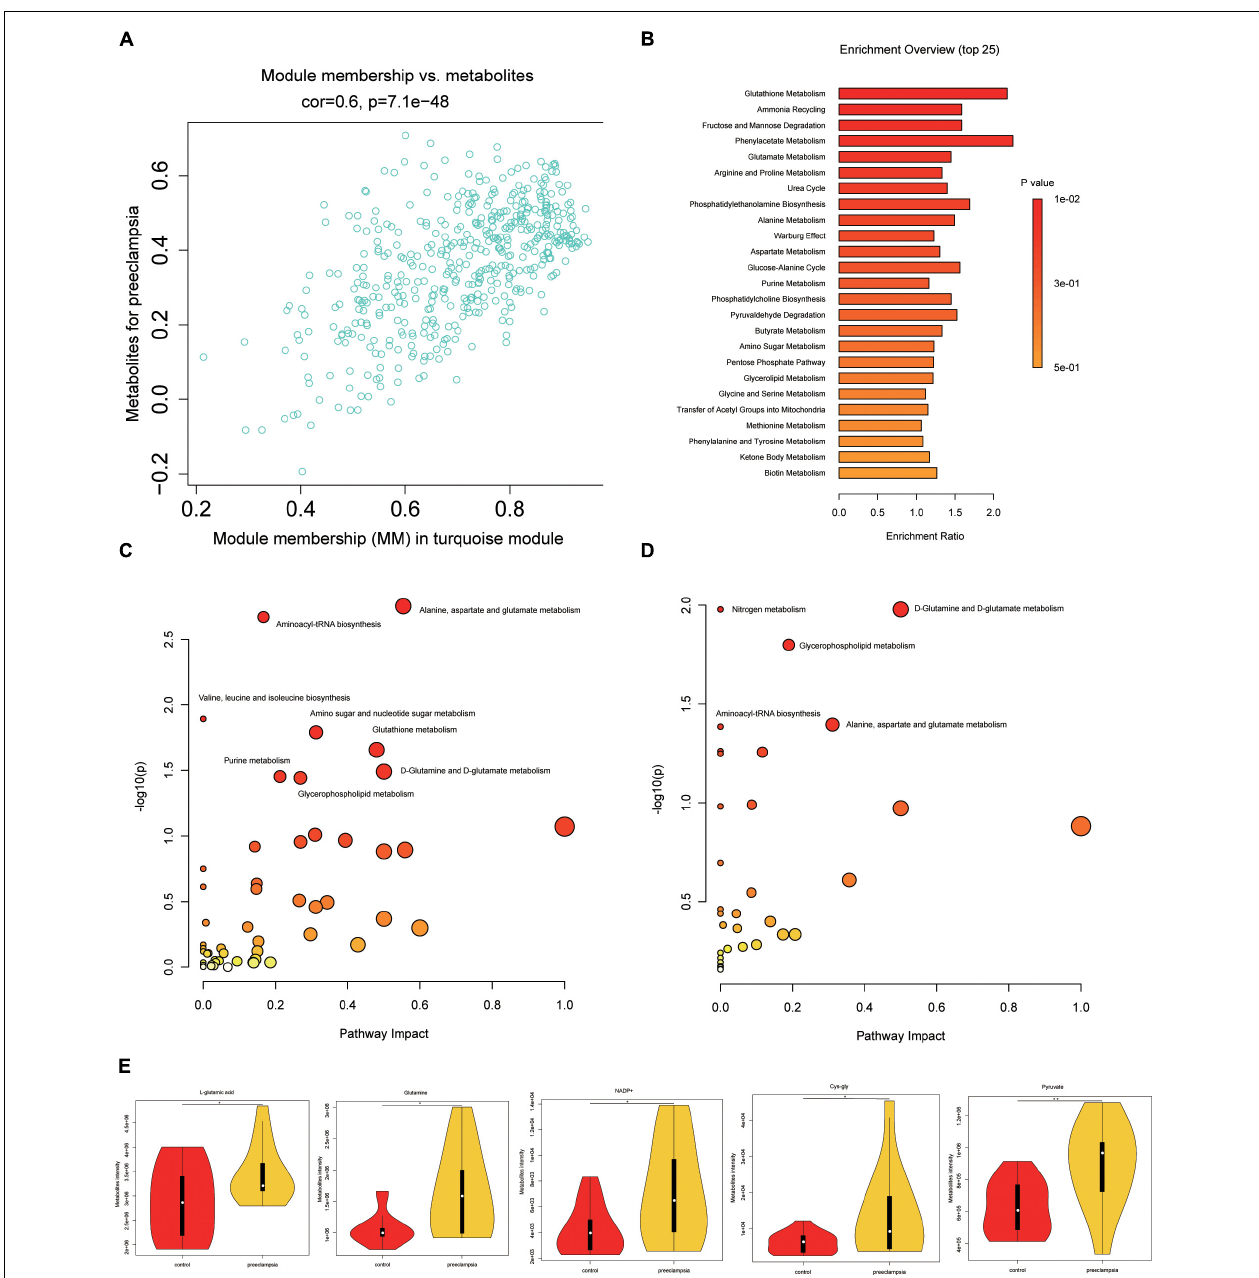
FIGURE 3 | Pathway analysis of metabolites in the turquoise module and significantly altered metabolites in preeclampsia placenta. (A) A scatterplot of metabolites for preeclampsia vs. Module Membership (MM) in the turquoise module. (B) Metabolite set enrichment analysis of turquoise block using SMPDB (Small Molecule Pathway Database). The bars are colored based on their p -values (lower p -values are redder), and the bar length is based on the enrichment ratio. (C) Metabolomic pathway analysis of turquoise block using the KEGG database. (D) Metabolomic pathway analysis of significantly altered metabolites (VIP > 1, p < 0.05) in preeclampsia using the KEGG database. The color gradient and circle size indicate the significance of the pathway ranked by p -values (yellow: higher p -values and red: lower p -values) and pathway impact scores (the larger the circle, the higher the impact score), respectively. Significantly affected pathways with a low p -value and high pathway impact score are identified by name. (E) The level of L -glutamic acid, glutamine, NADP+, cys-gly and pyruvate in placentas of the control and preeclampsia groups.